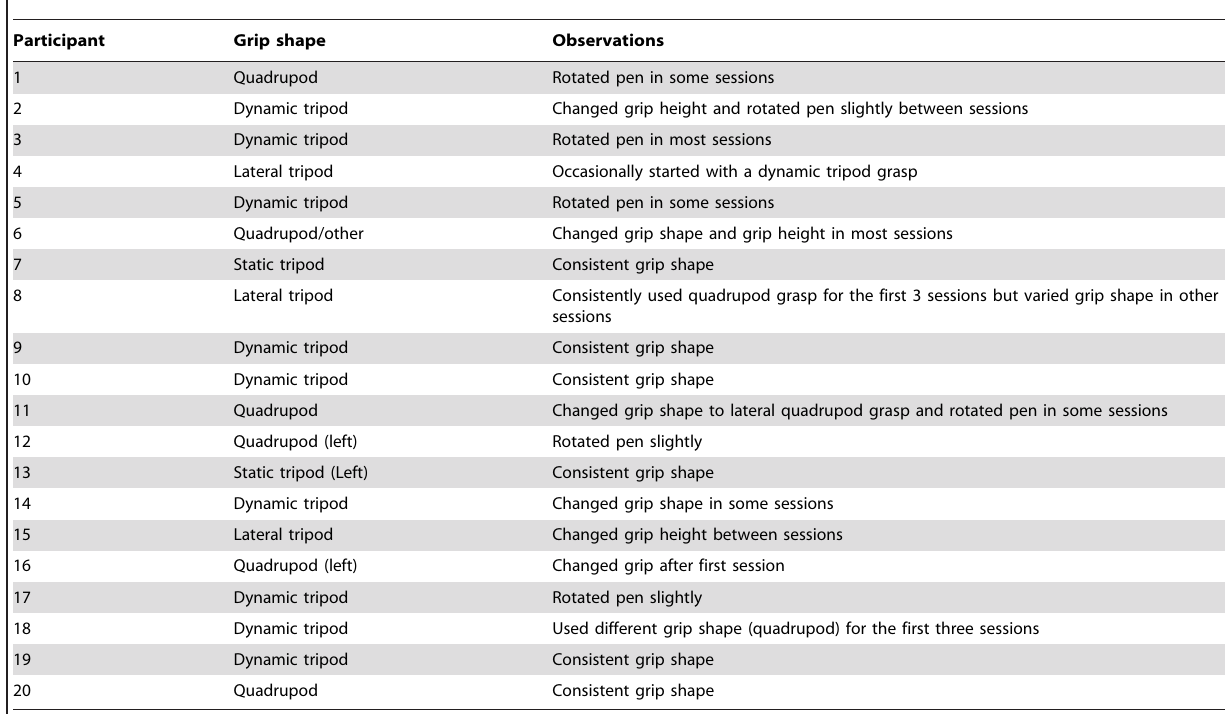
Table 2. Grip shape of each participant and associated observations.